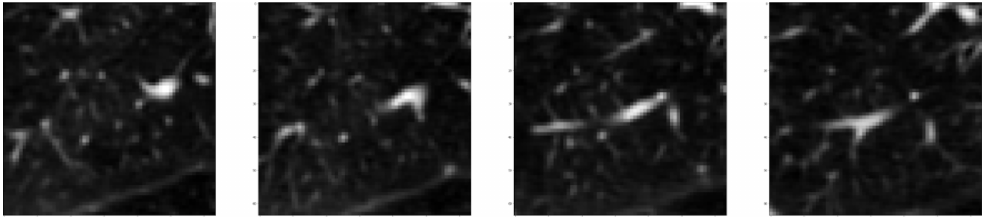
Figure 2. An example of a benign lung nodule from the CT scans.